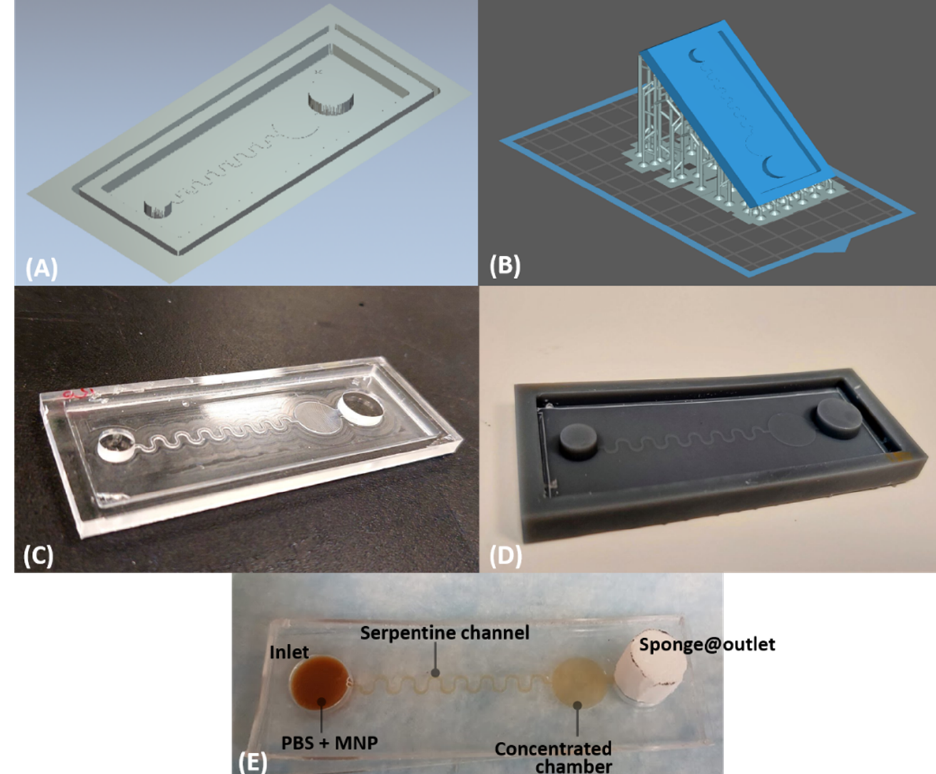
Figure 1. ( A ) Simulated micro-milling fabrication of the microfluidic mold in acrylic. ( B ) 3D model of the mold with 45 ◦ printing orientation using a raft support. Fabricated mold using ( C ) micro-milling and ( D ) SLA 3D printing. ( E ) Fabricated microfluidic chip for the test flow. The dimension of the microfluidic chip: total length = 75 mm; width = 25 mm; diameter of the inlet = 7.5 mm, diameter of the concentrated chamber and the outlet = 10 mm; height of the inlet and the outlet = 3 mm; height of the channel and the concentrated chamber = 250 µ m; width of the serpentine channel = 250 µ m; total length of the serpentine channel = 88 mm.